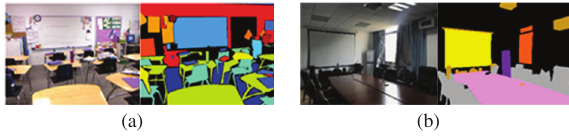
Figure 6. Example of semantic segmentation training dataset for SLENet.